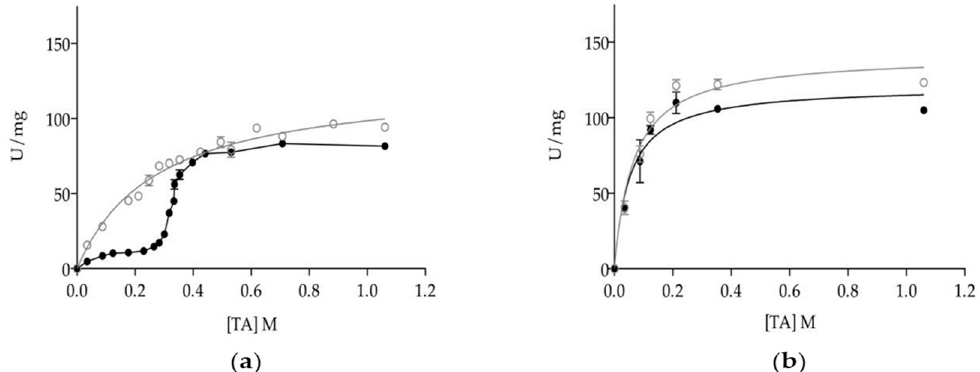
Figure 3. Dependence of specific activity of dLip3 ( ○ ) and mLip3 ( ● ) on triacetin concentration in the absence ( a ) and presence ( b ) of 25% ( v / v ) hexane. The assays were performed at 30 °C and pH 7.0. Triacetin concentration: From 35 mM–1.06 M. Lipase concentration: 80 μ M. Triacetin solubility limit was 270 mM. Data from mLip3 series was reproduced with permission from Pernas et al. [20].